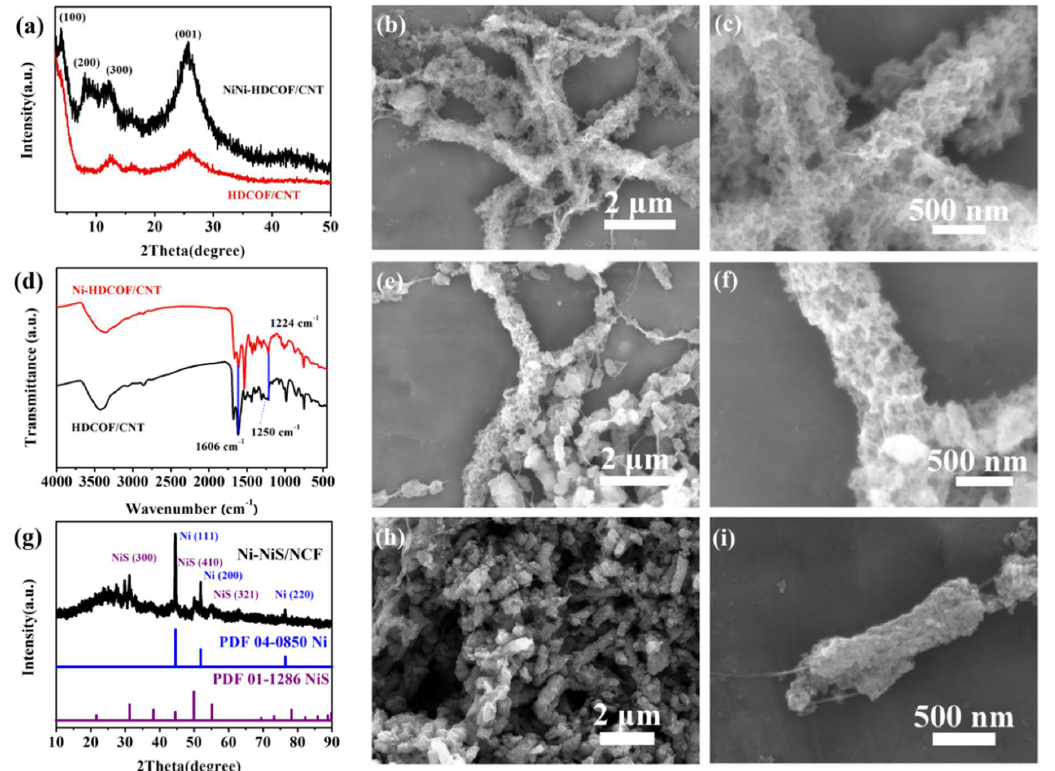
Figure 2. ( a ) XRD pattern of HDCOF and Ni-HDCOF/CNT. ( b , c ) SEM images of HDCOF/CNT. ( d ) IR spectrum of Ni-HDCOF/CNT. ( e , f ) SEM images of Ni-HDCOF/CNT. ( g ) XRD pattern of Ni-NiS/CNF. ( h , i ) SEM images of Ni-NiS/CNF.